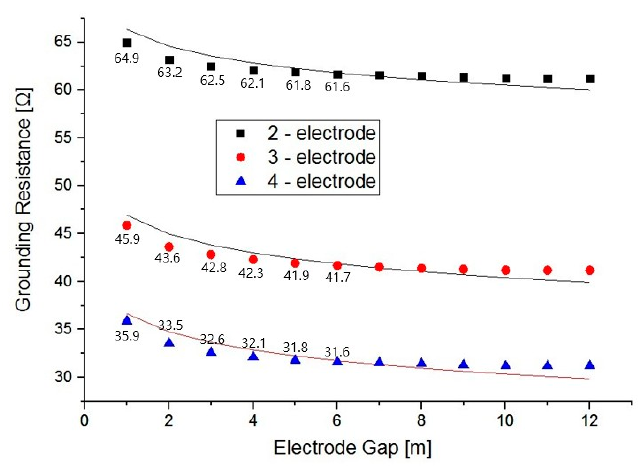
Figure 11. Comparison between grounding resistance and electrode gap.